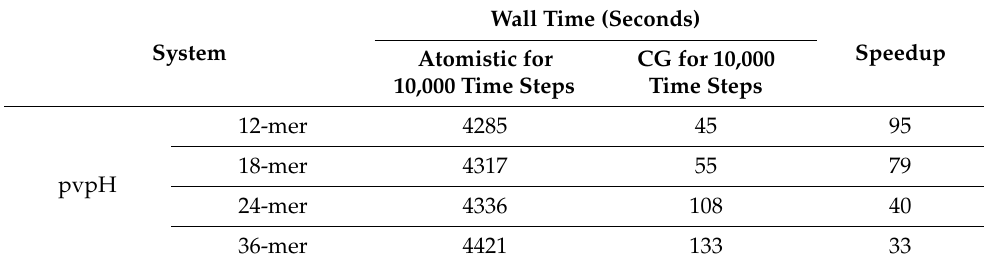
Table 1. Comparison of wall time (simulation run time) for atomistic and structurally best performing CG